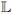
Results of the BFR applied to the numerical data.(a) showing from left to right three simulation samples and from top to bottom: raw simulation, GF, DIPF, MUBAFIRE correction and the reference field, b
ref; (b) shows the difference between corrected fields and b
ref. The cumulated DIPF and MUBAFIRE histograms of all 50 samples are shown in (c) in comparison to the reference. Finally, (d) shows correlation between L
1-norm and standard deviation of GF, SPHINX, DIPF and MUBAFIRE correction.